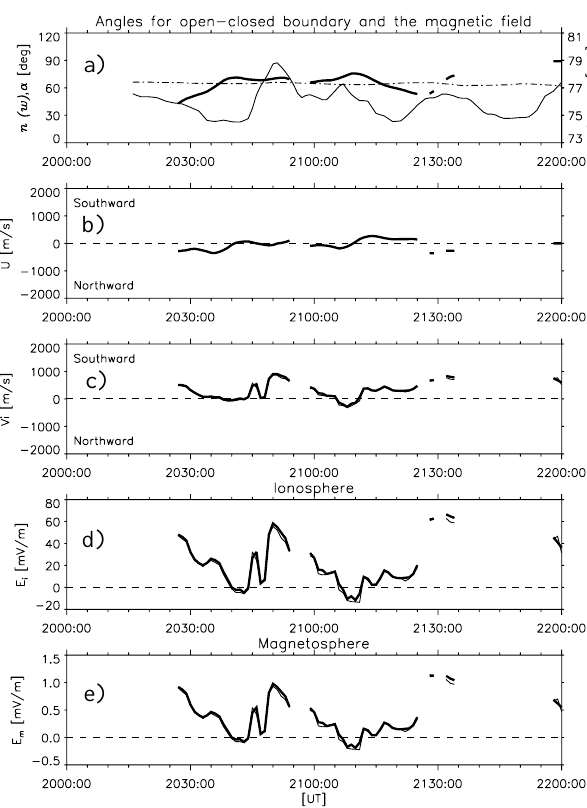
Fig. 5. The measurements along the north beam of the EISCAT VHF radar. The gate positions are mapped along the magnetic field line down to 100km altitude. Time resolution is 1 min. The four panels show ( a ) the electron density, Ne, ( b ) the electron temper- ature, Te, ( c ) the ion temperature, Ti and ( d ) the ion velocity, Vi, along the line of sight with positive values to the north. The open closed boundary inferred from the Te measurement is shown by solid lines. The thin line is the actual gate position and the thick line is the same boundary smoothed. The squares show the open- closed boundary inferred from the WIC images.